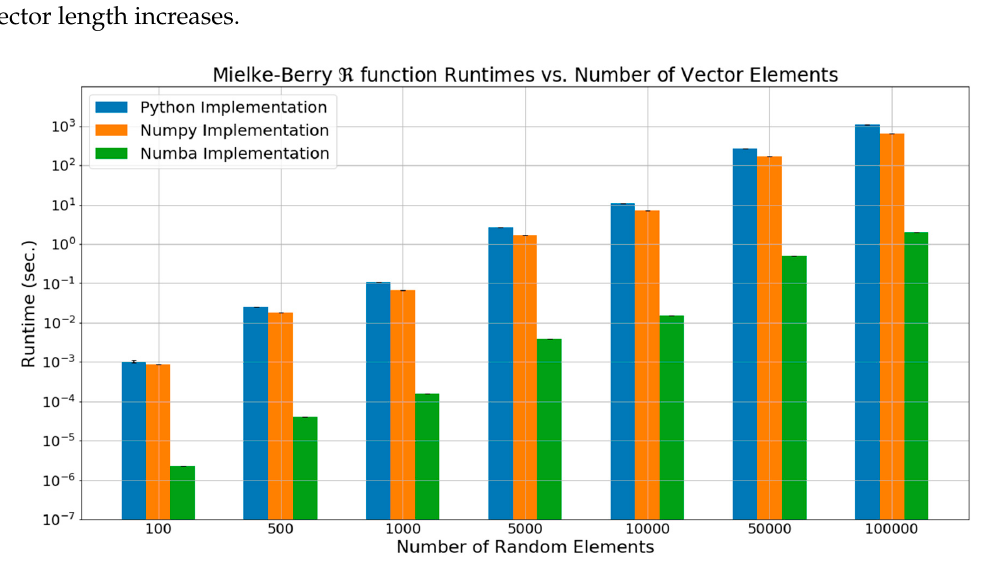
Figure 7. Runtimes for three different implementations of the Mielke–Berry R metric, plotted with a logarithmic vertical axis. Benchmarks were performed using 7.7 GB of RAM and an Intel ® Core TM i5-4590 CPU @ 3.30 Ghz x 4.